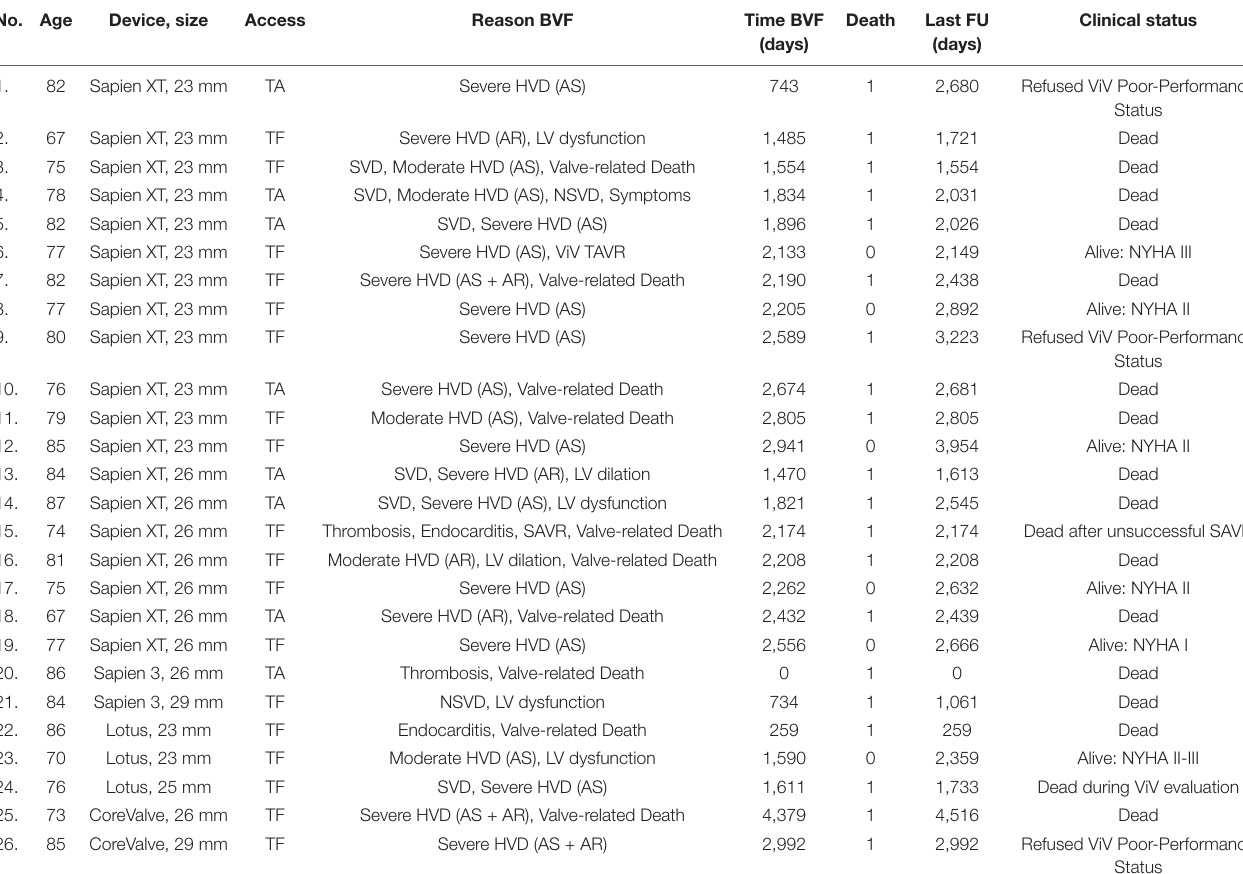
TABLE 3 | Bioprosthetic valve